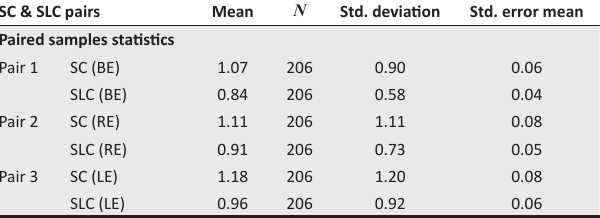
FIGURE 1: Box and whisker plots for the visual acuities scores obtained using the Snellen chart and Spectrum LogMAR chart for both eyes (OU), right eyes (OD) and left eyes (OS). TABLE 1: Descriptive statistics for Snellen chart and Spectrum LogMAR chart mean differences for both eyes, right eyes and left eyes and distance visual acuities in minimum angle of